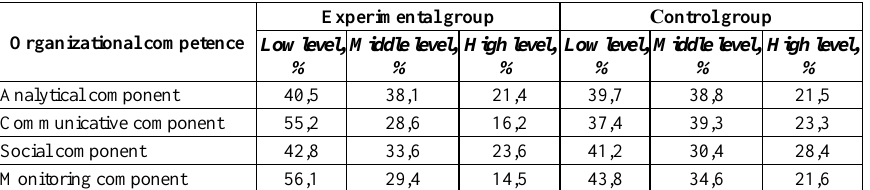
Table 2. Level of organizational competence in the experimental and control groups at the end of the experiment Organizational